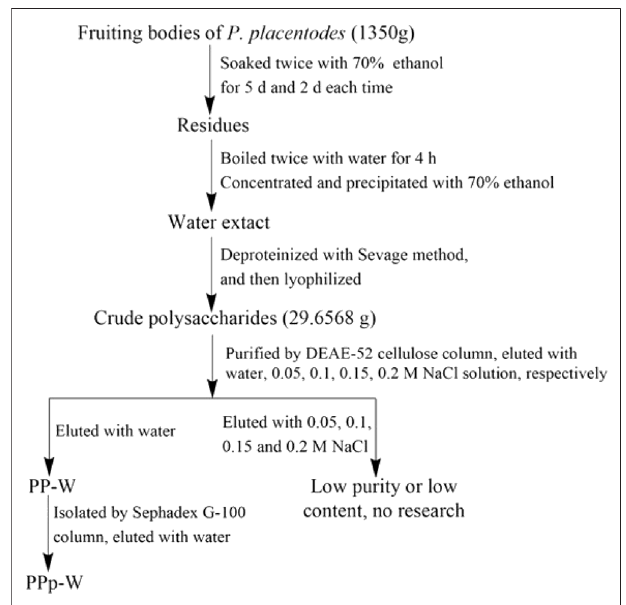
FIGURE 1 | The fl ow chart of extraction and separation of polysaccharides from P. placentodes